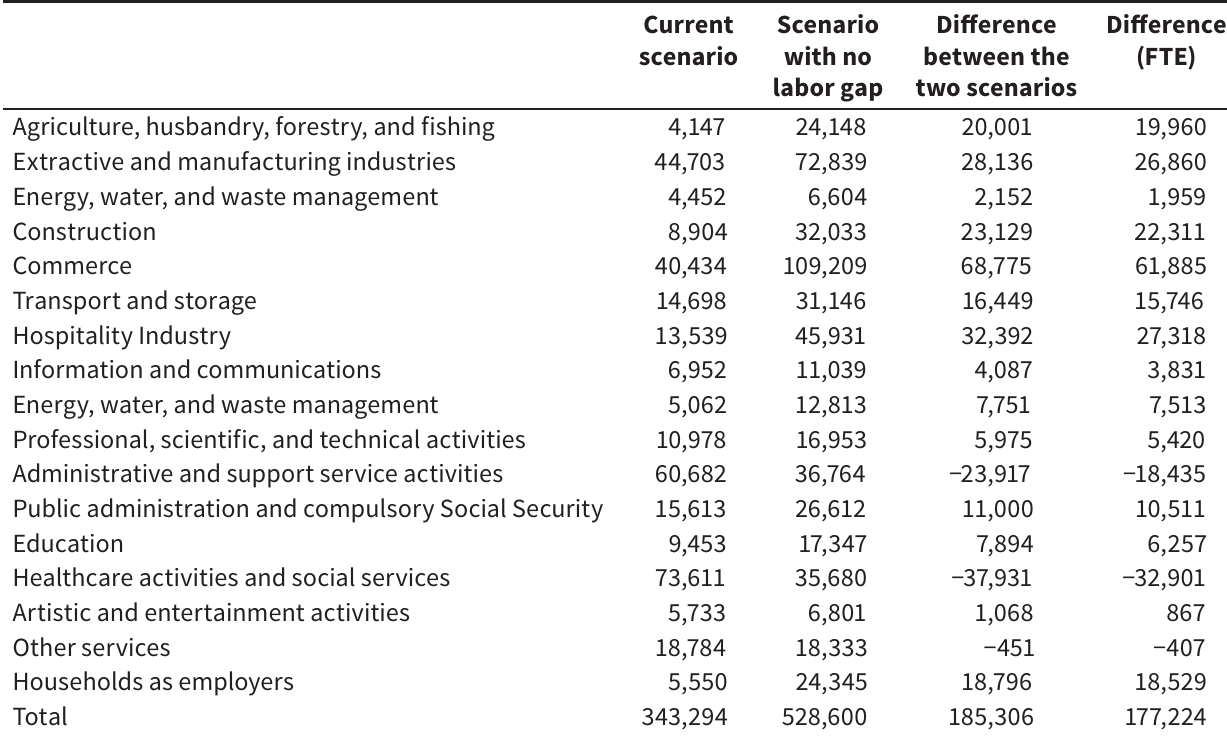
Current distribution of persons with disabilities in branches of activity and distribution referring to the Scenario with no labor